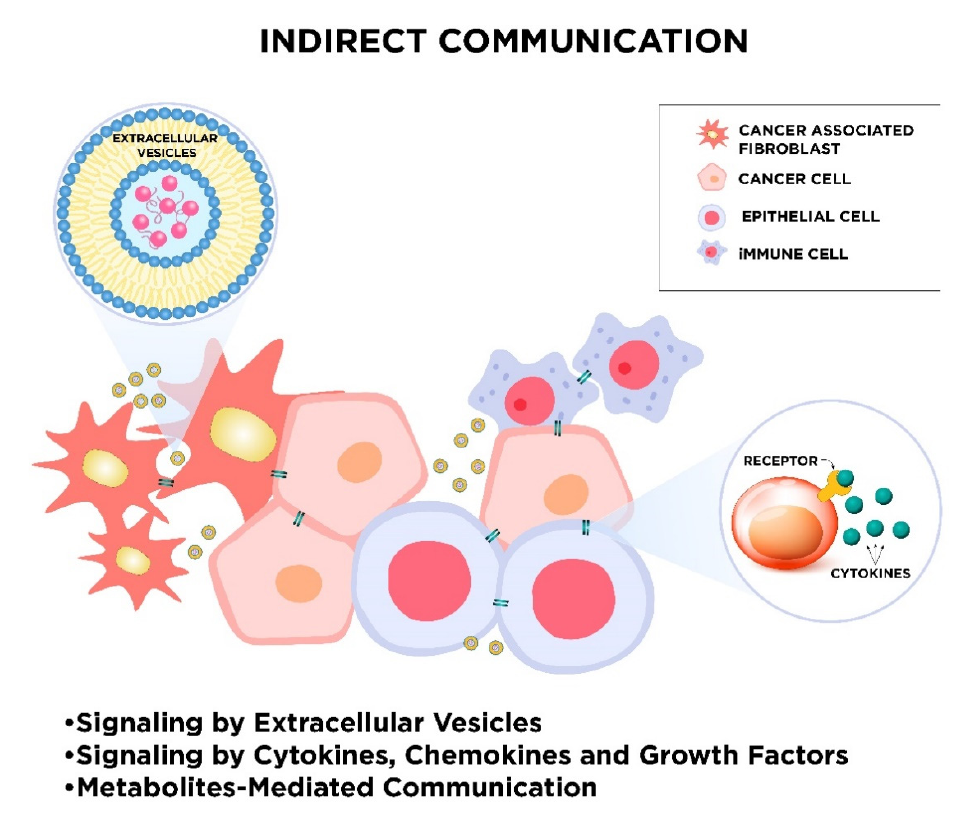
Figure 2. The schematic visualization of indirect communication in the tumor microenvironment. The sharing of information between cancer and stromal cells, such as non-cancerous epithelial cells, cancer-associated fibroblasts, immune cells, and others, can occur in different ways, e.g., via extracellular vesicles or through signaling by cytokines, chemokines, and growth factors as well as metabolites-mediated communication. Exosomes can transfer many bioactive molecules over long and very long distances. Secreted signaling molecules can also travel to remote cells.